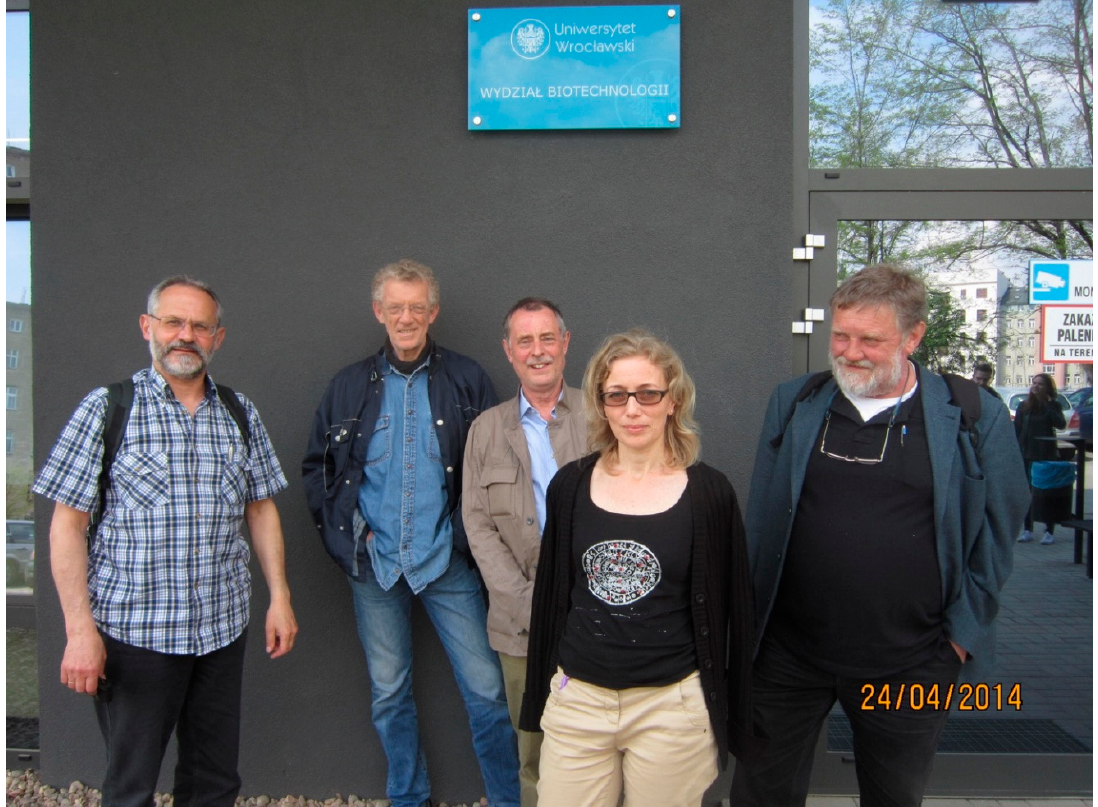
Figure 1. (L–R) Andrew Kutner, Rhodri Ceredig, Geoffrey Brown, Eva Marcinkowska, and Antonius (Ton) Gerardus Rolink at the Wroclaw DECIDE (decision-making within cells and differentiation entity therapies) consortium meeting in April 2014.